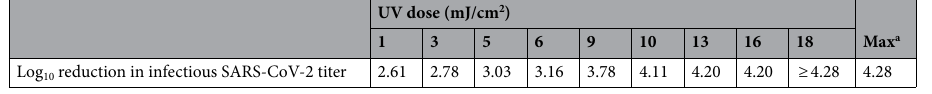
Table 2. UV irradiation dose as a function of Log 10 reduction in infectious SARS-CoV-2 titer. a Maximum reduction